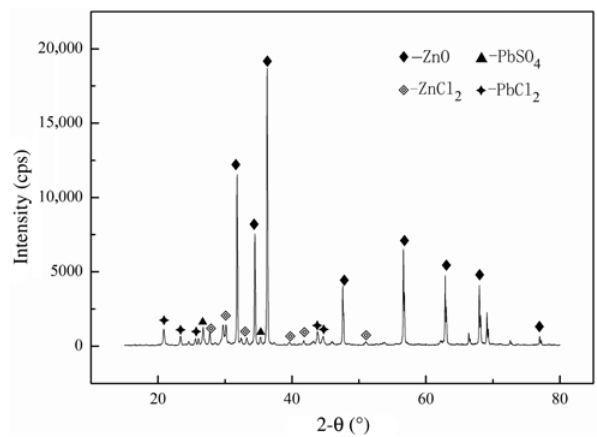
Figure 1: X-ray diffraction pattern of zinc oxide dust sample.